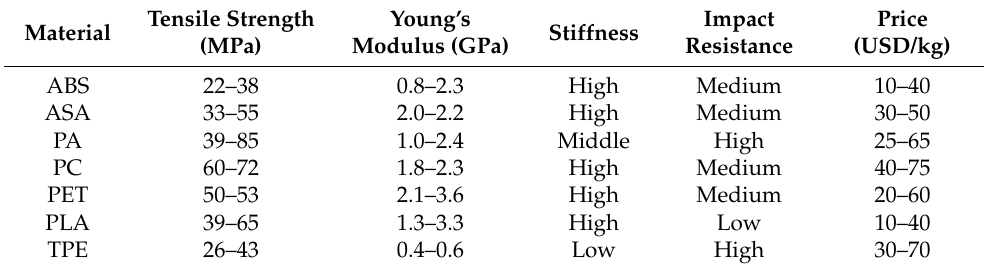
Table 1. Basic properties and price range for common FDM materials